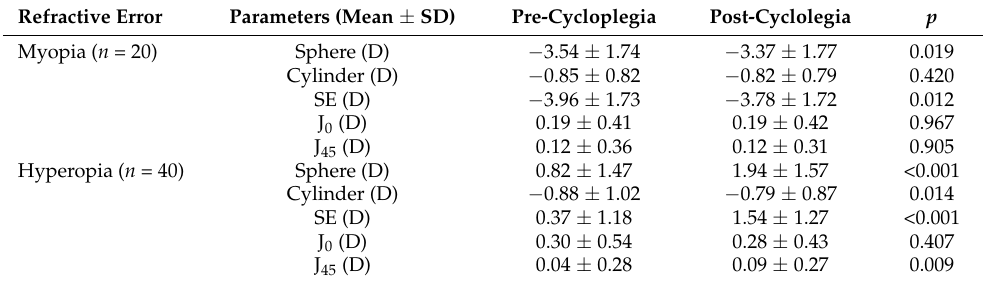
Table 2. Refractive components of both groups measured by VX130 with and without